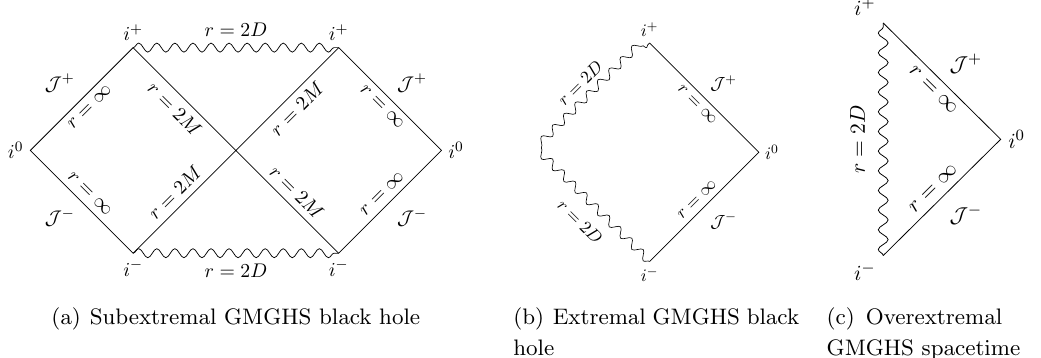
Figure 1 . Carter-Penrose diagrams representing the causal structure of GMGHS solutions for (a) the subextremal case M > D , (b) the extremal case M = D , and (c) the superextremal case M < D